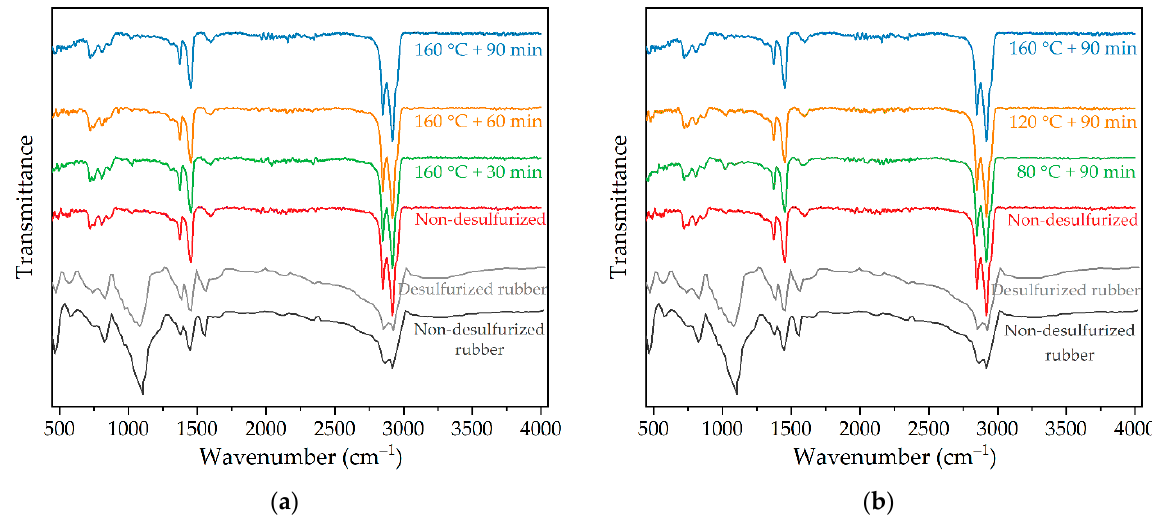
Figure 6. Fourier infrared spectroscopy of desulfurized crumb rubber powder modified asphalt: ( a ) with different mixing time; ( b ) with different mixing temperature.